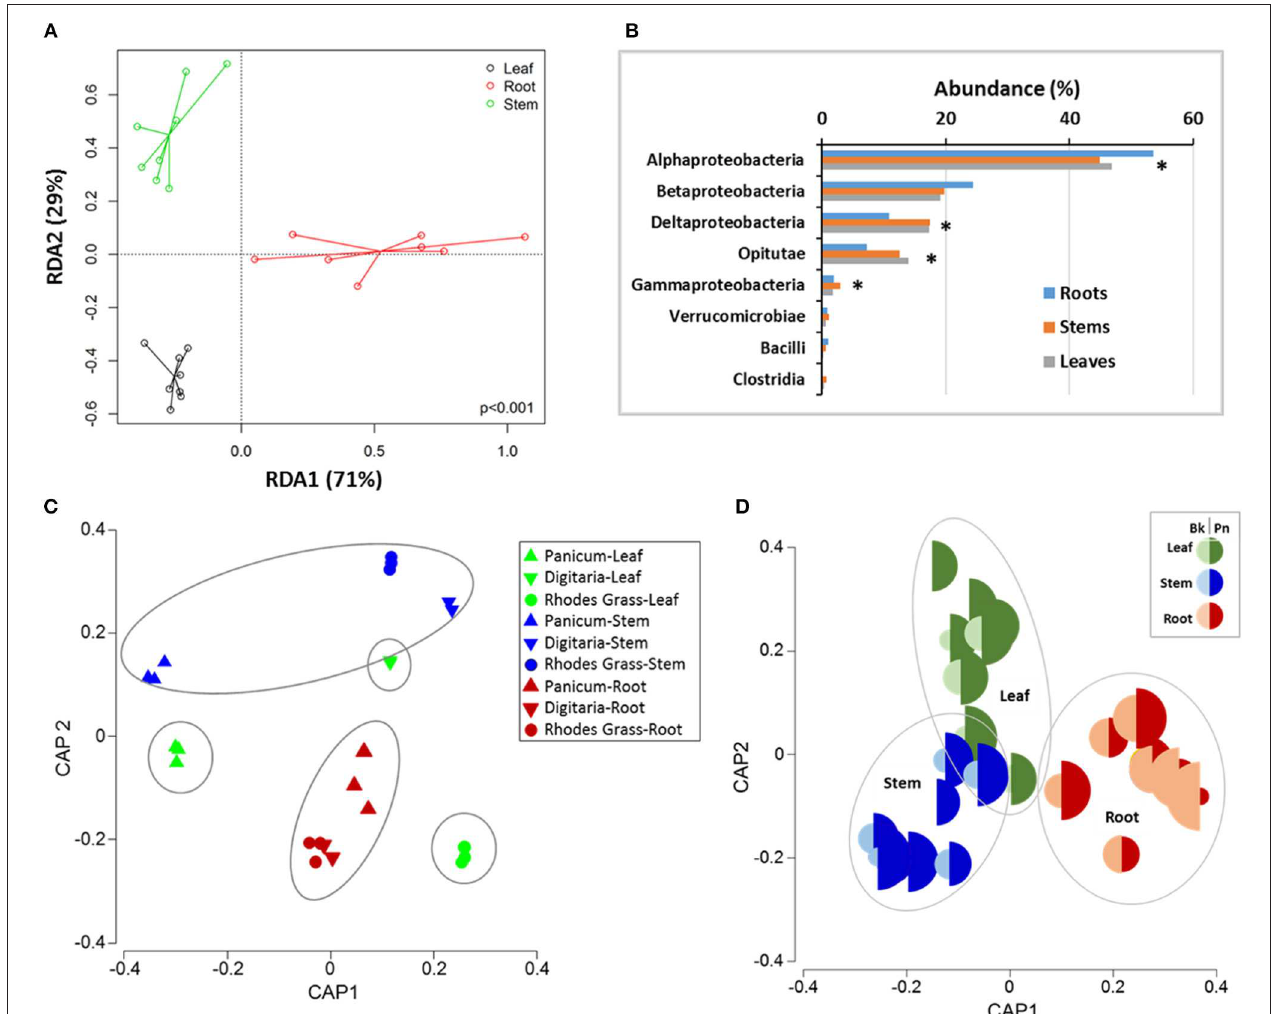
FIGURE 3 | Differences in the composition of nifH -gene harboring bacteria in the different above-ground plants parts and roots for the three grasses. (A) Redundancy analysis (RDA) for ordination under constraint of the plant parts, (B) relative abundances at Class level between different plant parts; * indicates significant differences at P < 0.05, (C) Canonical analysis of principle (CAP) ordination, constrained by plant part and species and (D) Relative abundance of Burkholderia sp (Bk, OTU378) and Polaromonas naphthalenivorans (Pn, OTU909) in different plant parts. PERMANOVA—Grass: CV = 5.87, P = 0.09; Plant part: CV = 13.7, P = 0.01; Grass x plant part: CV = 7.2, P = 0.19; Grass-plant part: CV = 13.529; P = 0.001; ANOSIM (plant parts): Global R 0.332; P =